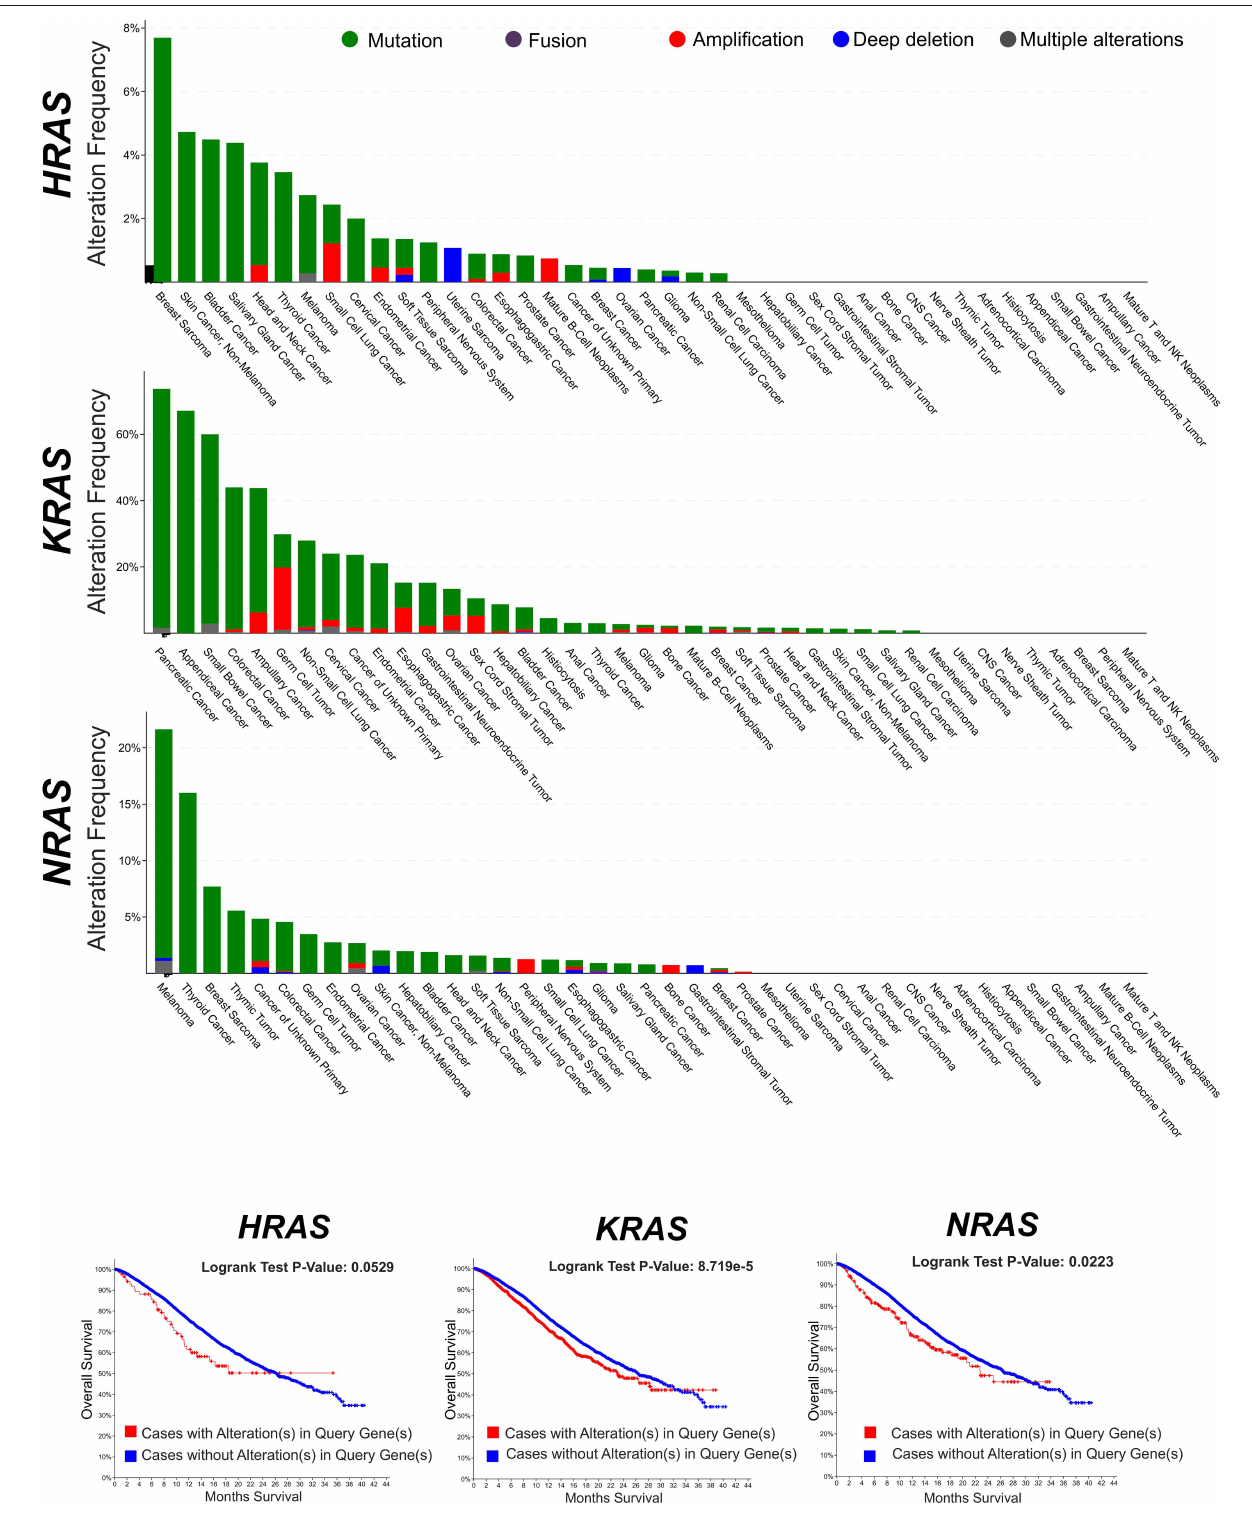
FIGURE 1 | Frequency of genomic alterations (mutation, fusion, amplification, deep deletion, multiple alterations) of the RAS genes ( HRAS, KRAS, NRAS ) across different tumor types of the MSK-IMPACT Clinical Sequencing Cohort (8). Data have been accessed through cBioportal for Cancer Genomics website (https://www.